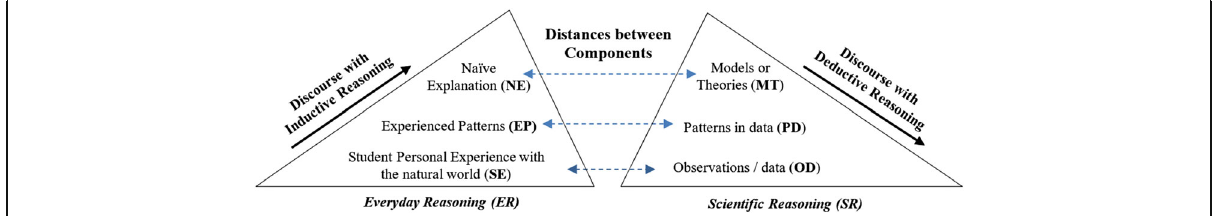
Fig. 1 During a series of dialogs, a teacher can help students transfer their reasoning from everyday reasoning to scientific reasoning. The distances between the components in each ER and SR illustrate the relative difficulty of transformations. Thus, the most difficult transformation would be from NE to MT and the best transformation could happen from SE to OD followed by EP to OD and NE to OD (adapted from Anderson ’ book, Teaching Science for Motivation and Understanding,